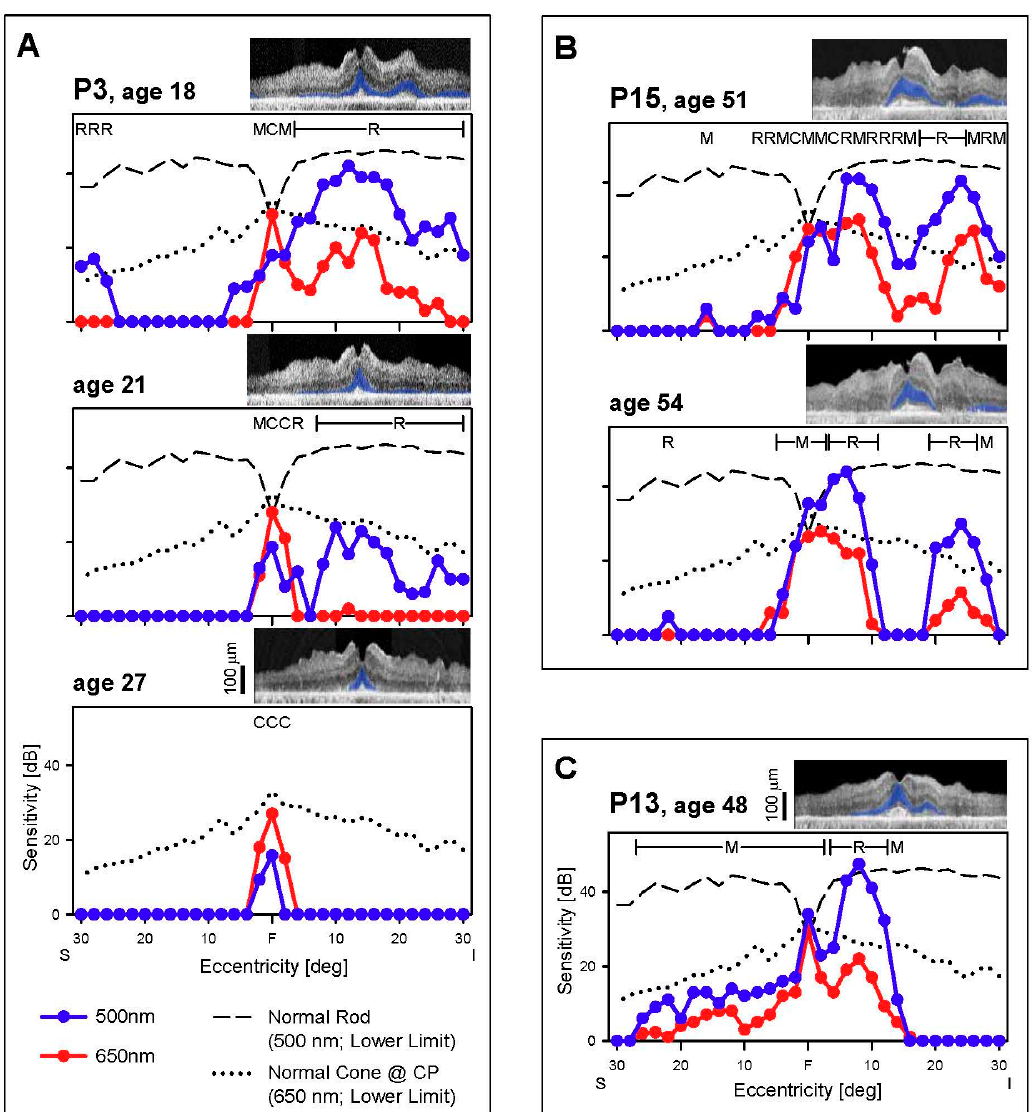
Figure 2. Rod and cone function across the vertical meridian. ( A – C ) Dark-adapted, two-color profiles measured across the central 60° in 3 EYS patients. Photoreceptor mediation of the 500 nm (blue symbols) and 650 nm (red symbols) stimuli is based on the sensitivity difference between the two colors and is shown above the data: R, rod; M, mixed rod and cone; C, cone-mediated. Interrupted lines are the lower limit of normal sensitivity (-2SD) for rods to the 500 nm stimuli (long dashes) and for cones to the 650 nm stimuli (dots). All three patients present with abnormal rod and cone function and this further diminishes, as demonstrated in the two patients with serial data (P3, P15). Insets, Optical coherence tomography (OCT) images colocalized with perimetry; outer nuclear layer (ONL) colorized blue for visibility. F, fovea; S, superior and I, inferior visual field.